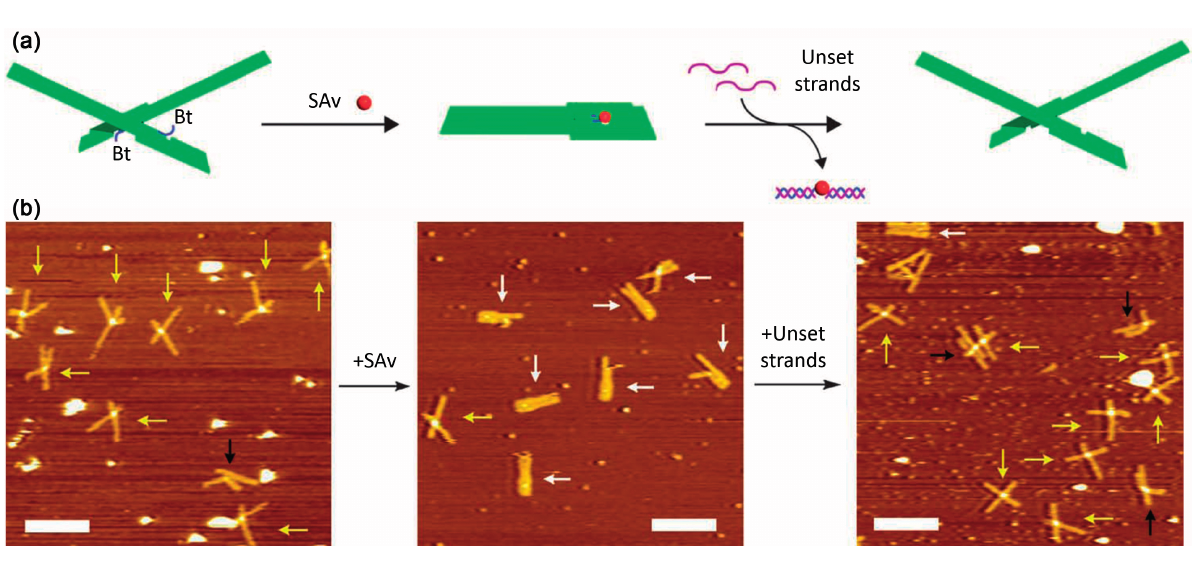
Figure 11. ( a ) Shape transition of the nanomechanical DNA origami device upon SAv binding and release; ( b ) Corresponding AFM images. Adapted by permission from Macmillan Publishers Ltd: Ref. [38], copyright